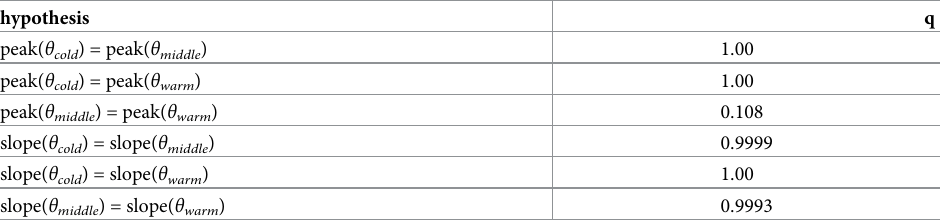
Table 3. Pairwise comparisons of hypotheses with credibility